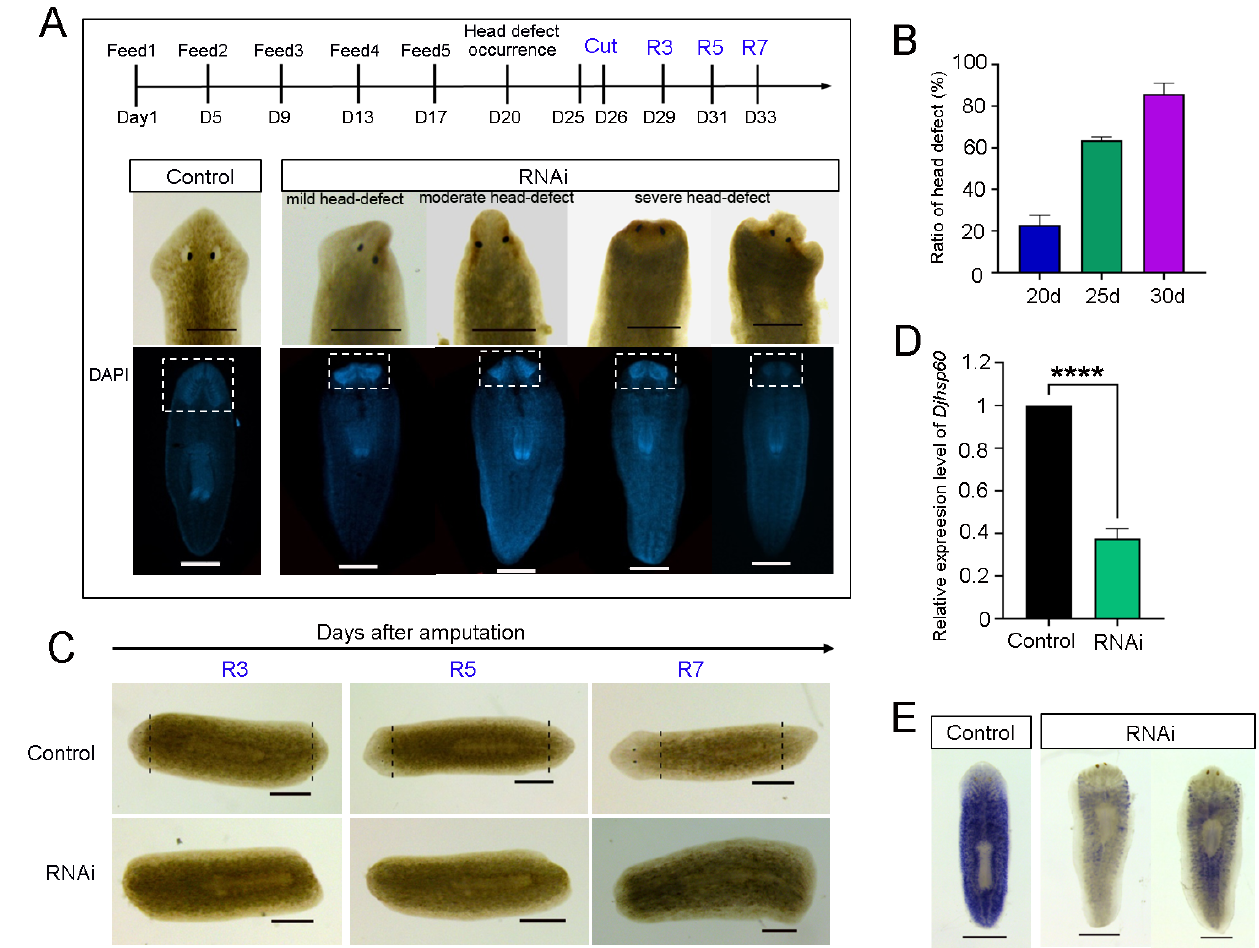
Figure 3. Phenotype observation of Djhsp60 -RNAi animals. ( A ) Live images of head-defective animals and brain structure revealed by DAPI staining after 25 days of dsRNA exposure. Brain structure was boxed. ( B ) Ratio of head-defects occurrence after RNAi. Three individual RNAi experiments were used for statistics. ( C ) Effects of RNAi on planarian regeneration. ( D ) Endogenous mRNA expression levels of Djhsp60 after RNAi was detected by qPCR. Asterisks indicate statistical differences (**** p < 0.0001). ( E ) Expression of Djhsp60 after RNAi was shown by WISH. Color development for 45 min. n = 6 animals. Scale bar: 0.5 mm.